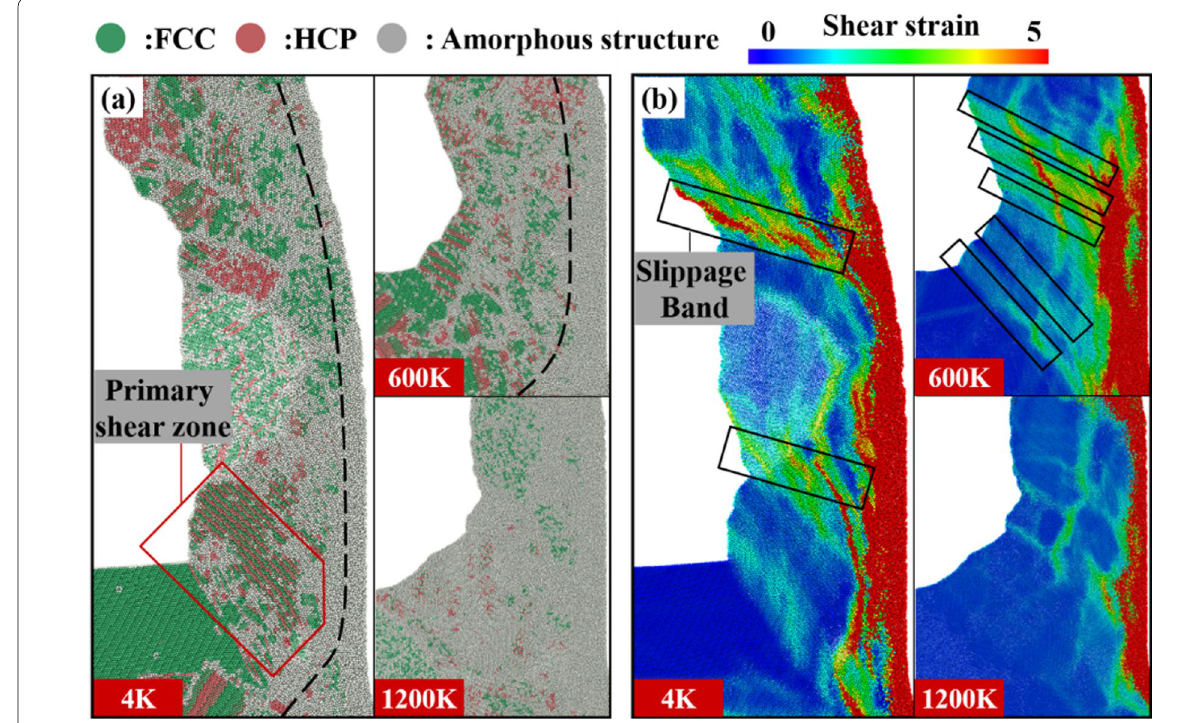
Fig. 8 Chip morphology at different temperatures, a crystal structure, b shear strain